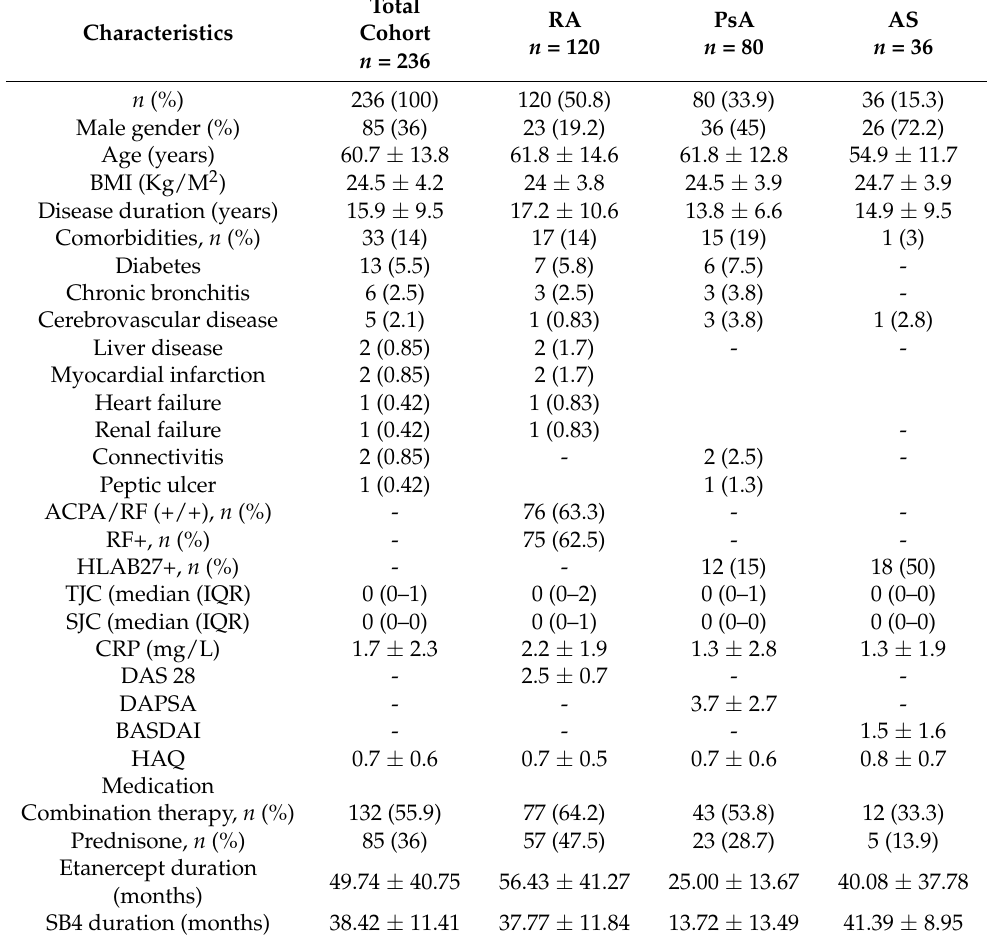
Table 1. Baseline characteristics of RA, PsA and AS